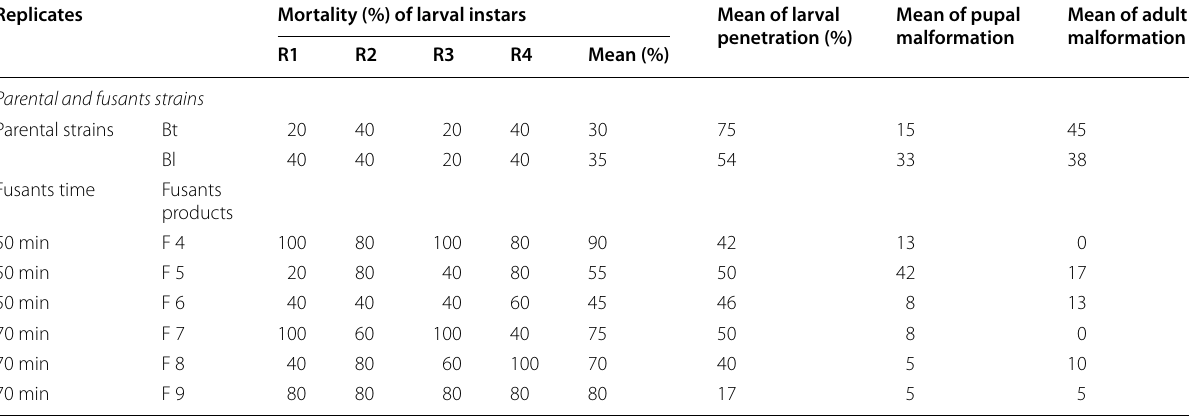
Table 4 Effect of different fusants of ( Bt::B1 ) on a biological feature of the Phthorimaea operculella Replicates